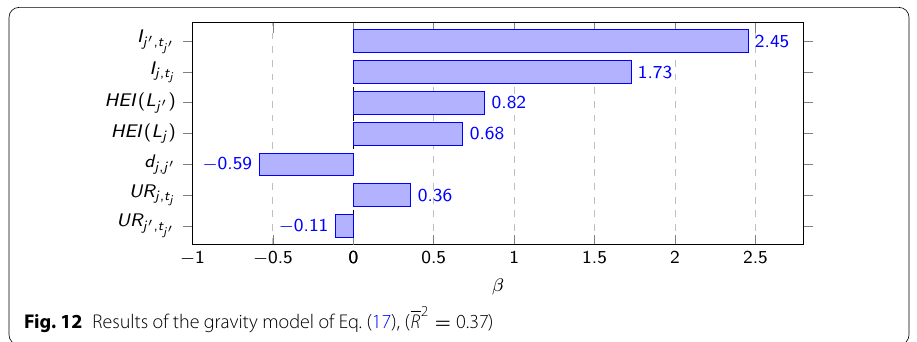
Fig. 12 Results of the gravity model of Eq. (17), ( R